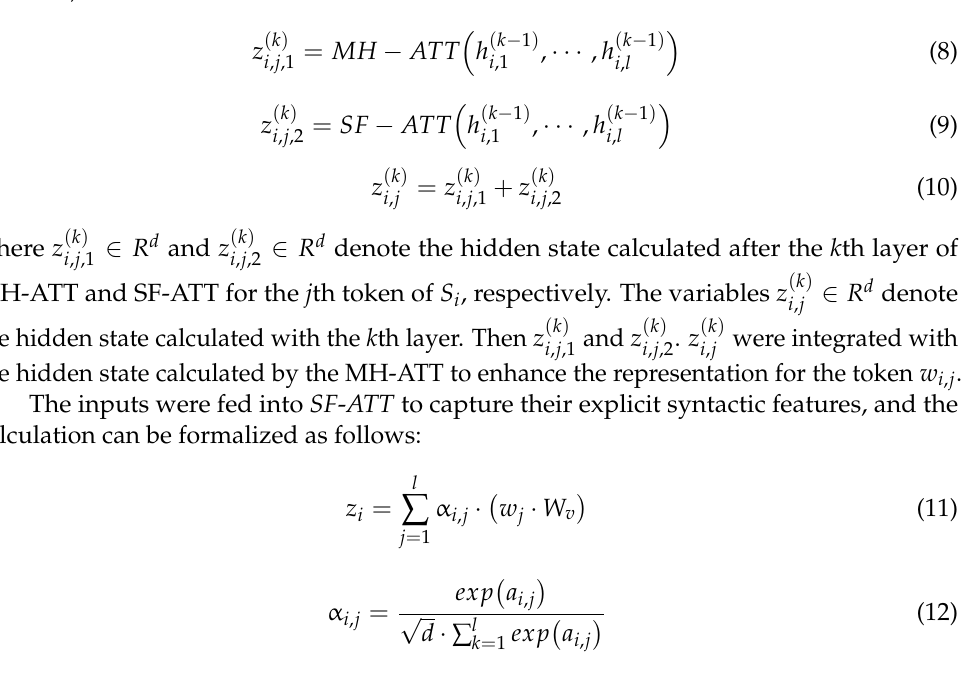
Figure 4. The overall workflow of Syntactic Feature Mask matrix construction and the architecture of Transformer-M encoder. ( a ) We first use the dependency parser tool (Stanford core NLP) to perform dependency analysis and obtain the dependency tree; ( b ) with the dependency tree, we can quickly obtain the connection matrix for the input sentences; and ( c ) we then obtain the mask matrix; ( d ) the overview of the Transformer-M is shown in ( d ), where the key component is the syntactic feature attention, which is designed to model the syntactic features of the input sentences. As shown in Figure 4a, for the given document and sentences 𝒟 = {𝑆 (cid:3036) } (cid:3036)(cid:2880)(cid:2869)(cid:3015) (cid:3294) , we first applied the Spacy tool to construct the dependency relation for each token 𝑤 (cid:3036),(cid:3037) ∈ 𝑆 (cid:3036) and its parent. We were then able to obtain the dependency paths and the link matrix could be constructed with them. Subsequently, we were able to construct a syntactic feature mask matrix for the input sentence, which was used in TF - M . To be specific, in the 𝑖 th layer of TF - M , the Syntactic Feature Attention and Multi-head Attention ( MH - ATT ) hid- den states were taken together to enhance the representations for each token in the input sentence; the former mainly focuses on the syntactic relations of 𝑤 (cid:3036),(cid:3037) ∈ 𝑆 (cid:3036) and its parent, and the latter is responsible for modelling the whole lexical and semantic features for all tokens in the sentence, which can be formalized as follows: